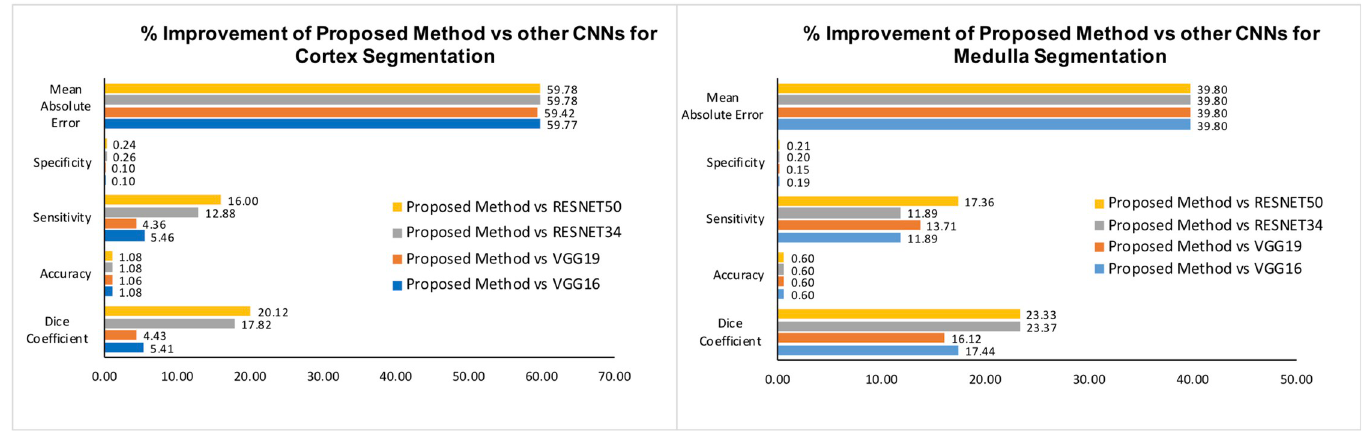
Fig 3. Evaluation metrics in terms of percentage improvement of the proposed method (RCM U-Net), with respect to VGG16 [15], VGG19 [17], ResNet34 [18], and ResNet50 [19], of cortex and medulla segmentation. These bar charts confirm the significant percentage improvement of the proposed method (RCM U-Net) over conventional